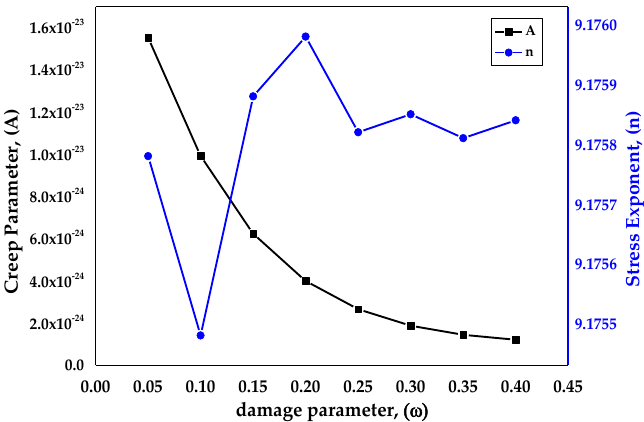
Figure 6. Effects of damage evolution on creep parameters at 650 °C.